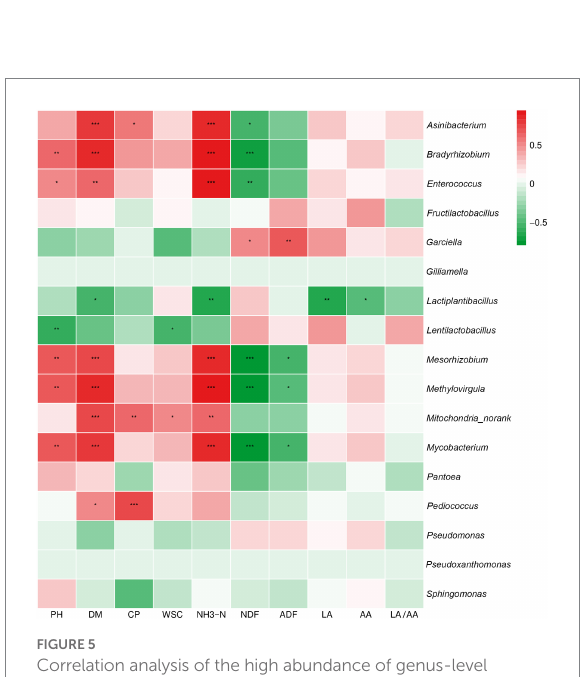
FIGURE 5 Correlation analysis of the high abundance of genus-level bacteria and fermentation quality in silage from different alfalfa varieties. * p < 0.05, ** p < 0.01, and *** p < 0.001,